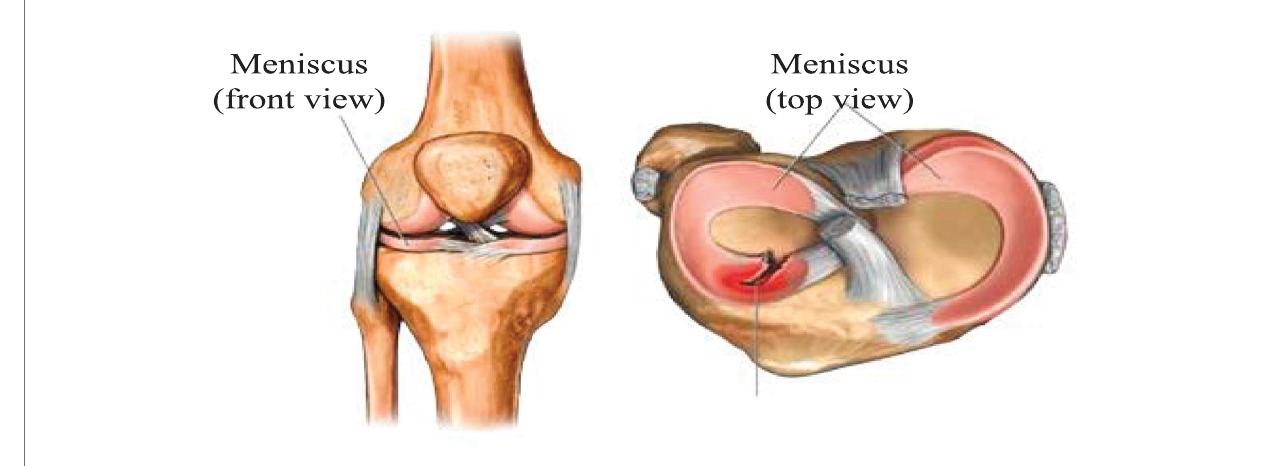
FIGURE 6 | Meniscal fi brochondrocytes.